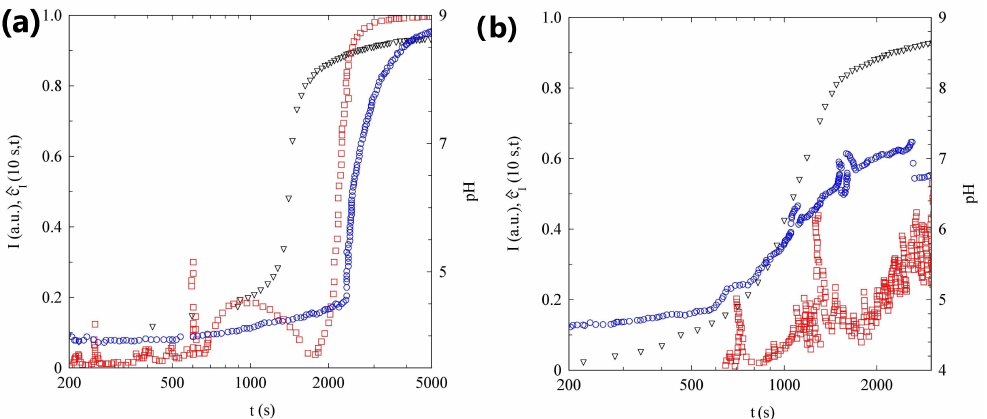
Figure 4. ( a ) Temporal evolution of pH (triangles), scattered intensity (circles), and ˆ c I ( 10s, t ) (squares) of sample H. ( b ) Temporal evolution of pH (triangles), scattered intensity (circles), and ˆ c I ( 10s, t ) (squares) of sample